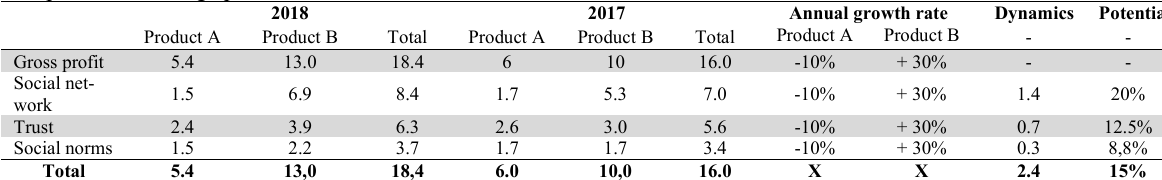
Competitive advantage potential